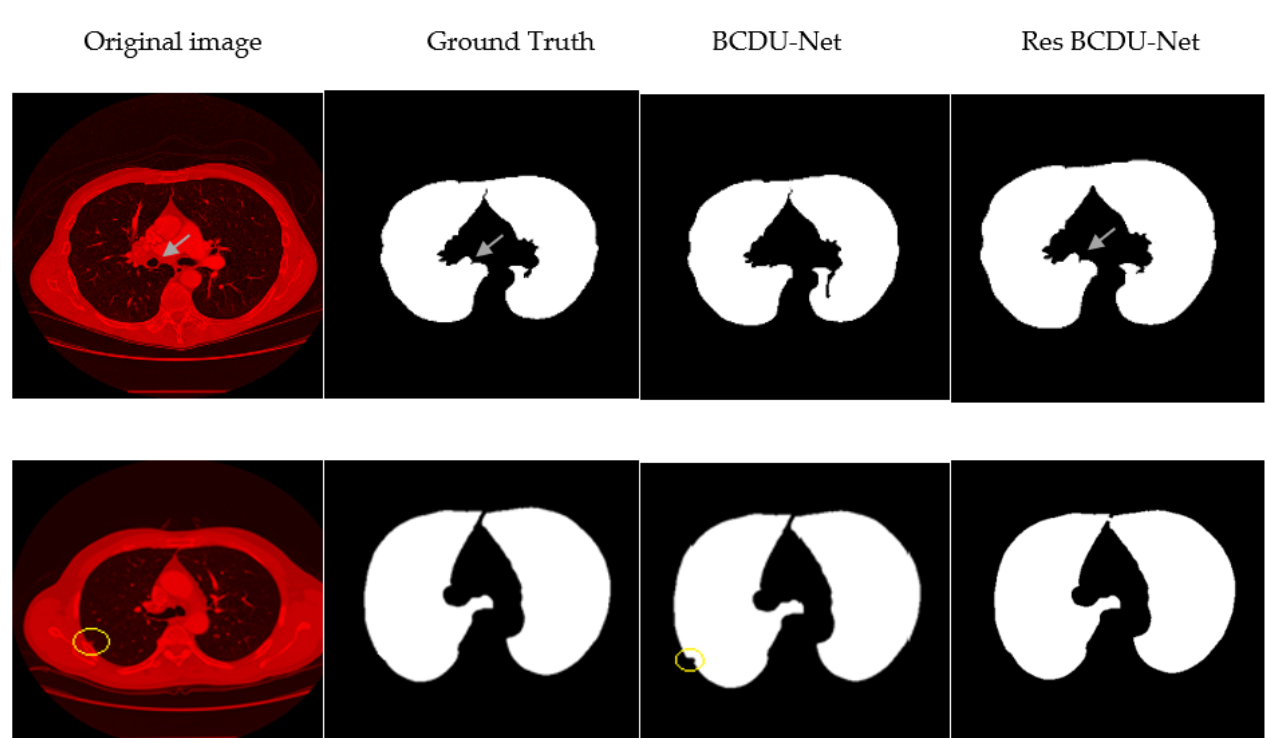
Figure 17. Visualizes the challenges for segmentation. First row presents the challenge of considering micro pulmonary tissues in the segmented image as the non-pulmonary region causing high false positive. Second row presents the challenge of losing attached nodules to the lung wall. (A yellow circle wrapped around the center of the nodule). The overall performance of our proposed method, the ROC curve and also the accuracy of training and validation proposed network for LIDC-IDRI dataset are shown in Figure 18.